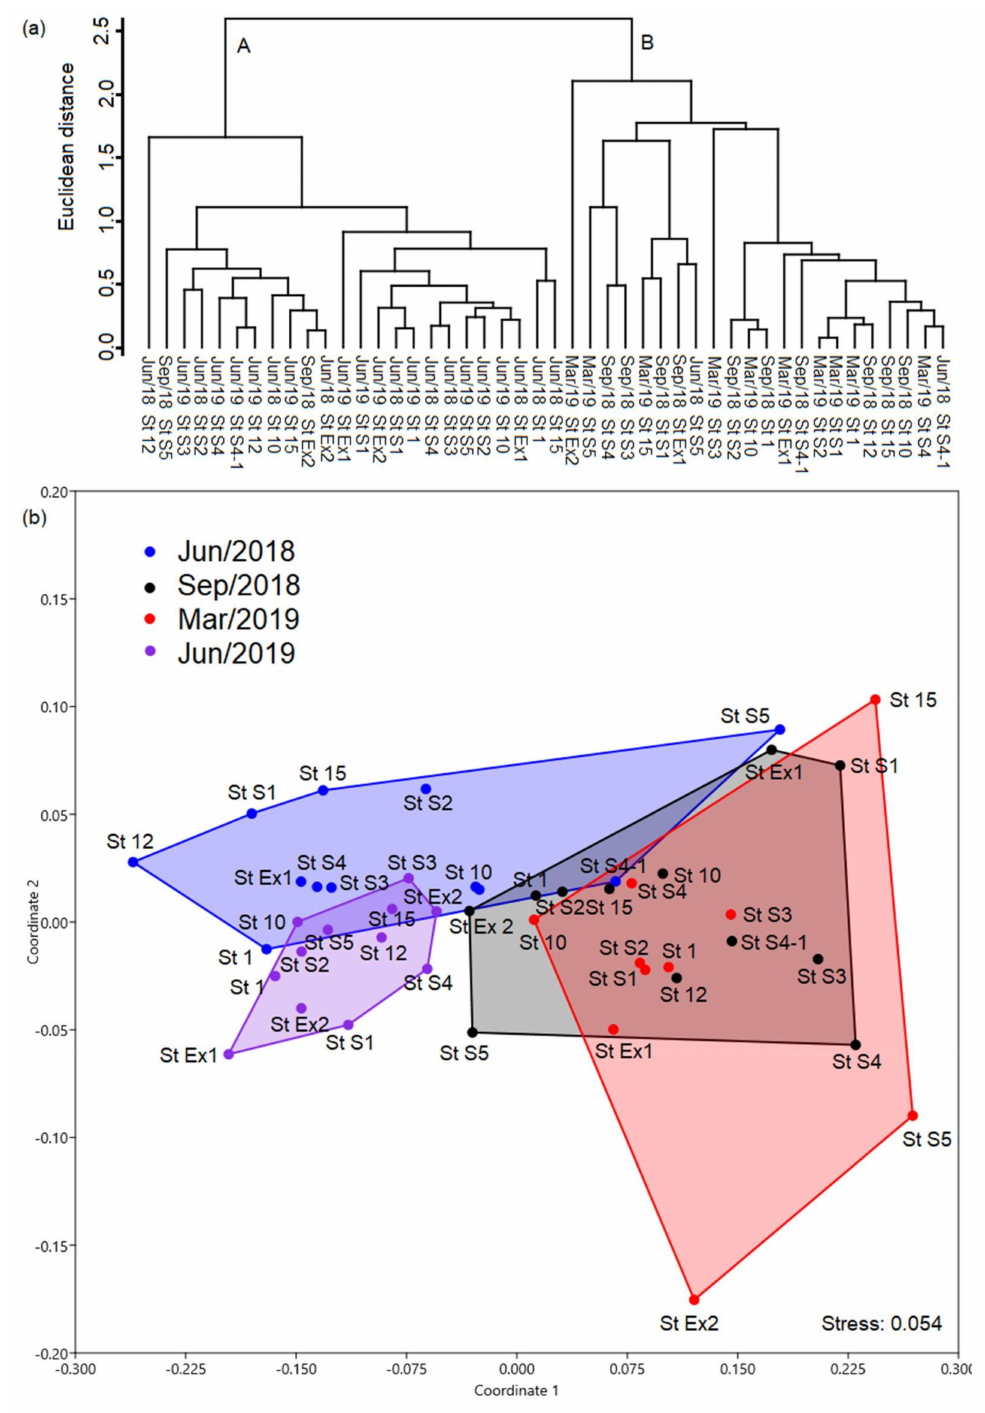
Figure 5. Clustering dendrogram of different Temora turbinata samples using Euclidean distances and clustering strategy of flexible links in the area off Northeastern Taiwan ( a ), and nonmetric multidimensional scaling of all samples ( b